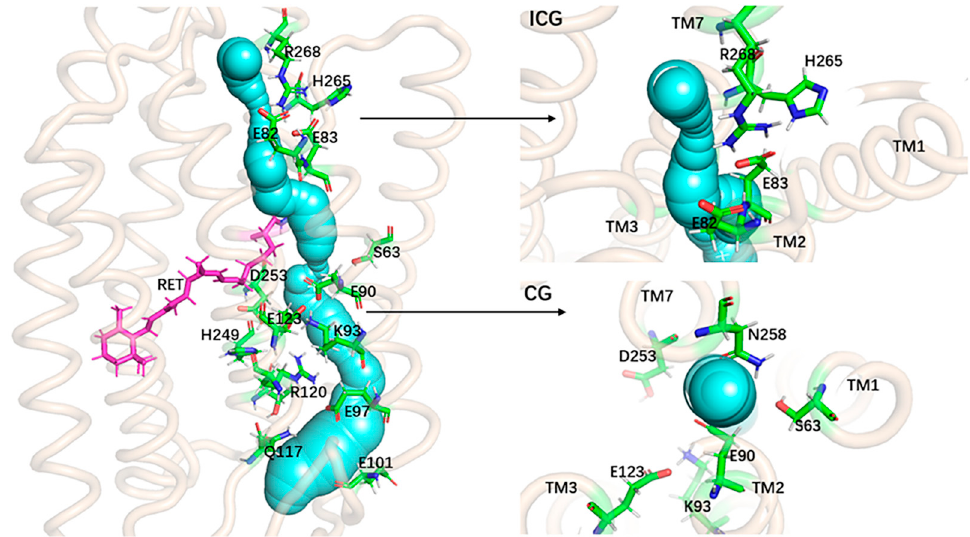
Figure 8. The static structure of the ion channel in the ChR2-cis. On the left is the overall view of the ion channel; the right side respectively is the side view of the channel at the ICG and the top view of the channel at CG.